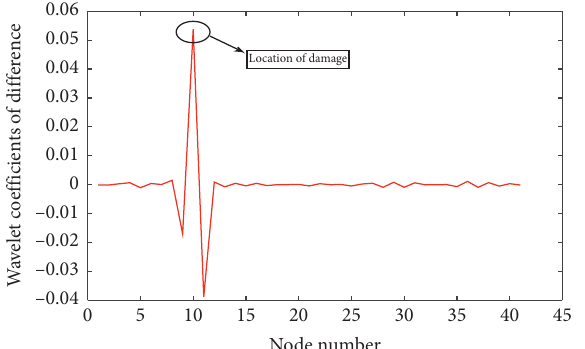
Figure 5: Wavelet coefficient difference graph for 10% damage in section